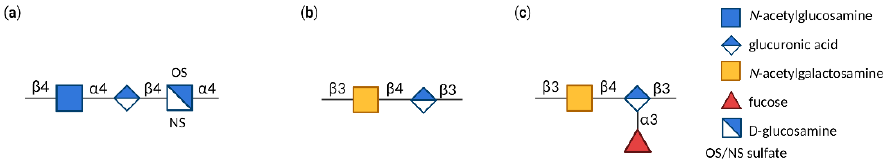
Figure 4. Structures of glycosaminoglycans (GAGs): ( a )/heparan sulfate (HS), ( b ) chondroitin sulfate (CS), ( c ) fucosylated chondroitin sulfate (FucCS). Created with BioRender.com (accessed on 30 September Full-length P . falciparum merozoite surface protein 1 (MSP-1), the most abundant